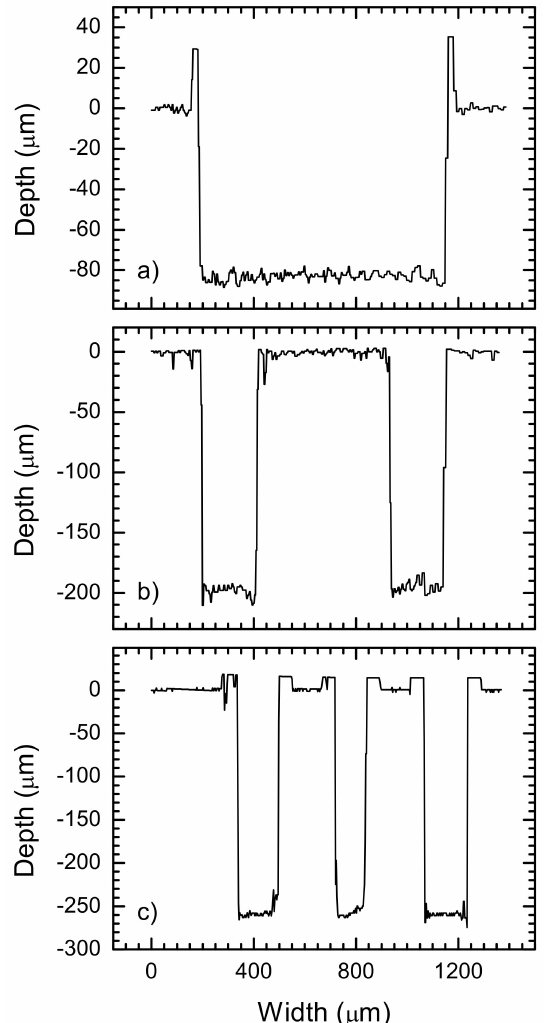
Figure 6. Profiles of select places after laser formation obtained by confocal microscope for micromachining process with scanning speed—100 mm / s, hatching distance—10 µ m ( a ) and 5 µ m ( b and c ), average power—9.5 W, ( a and b ) and 5 W ( c